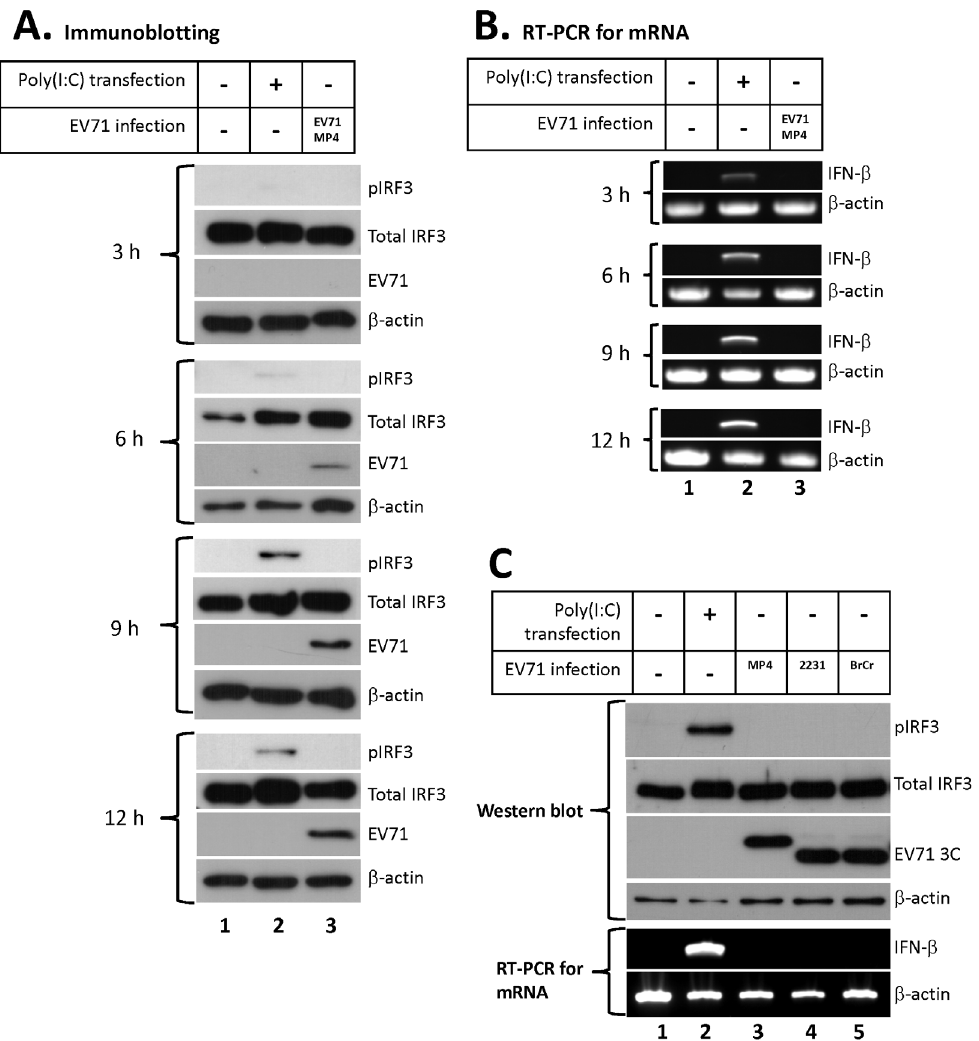
Figure 1. IRF3 is not activated during EV71 infection. HeLa cells were transfected with 10 m g of poly(I:C) or infected with MP4 strain of EV71 at 2 MOI. Cell extracts and total RNA were collected at 3 h, 6 h, 9 h, and 12 h post-transfection or post-infection. Immunoblotting was performed for detecting the presence of phosphorylated IRF3 (pIRF3), total IRF3, EV71 (by anti-EV71 antibody, MAB979, Millipore), and b -actin in the extracts (A). The expression of IFN- b and b -actin mRNA were analyzed by RT-PCR and agarose gel electrophoresis (B). (C) HeLa cells were transfected with 10 m g of poly(I:C) or infected with the MP4, the TW2231, or the BrCr strain of the EV71 virus at 2 MOI. Cell extracts and total RNA were collected at 12 h post- transfection or post-infection. The extracts were analyzed by immunoblotting using anti-phspho-IRF3 (pIRF3), total IRF3, anti-EV71 3C, and anti- b - actin antibodies. Total RNA was analyzed using RT-PCR and agarose gel electrophoresis to detect IFN- b mRNA expression. (MP4, EV71 MP4 strain; 2231, EV71 TW2231/98 strain; BrCr, EV71 BrCr strain).